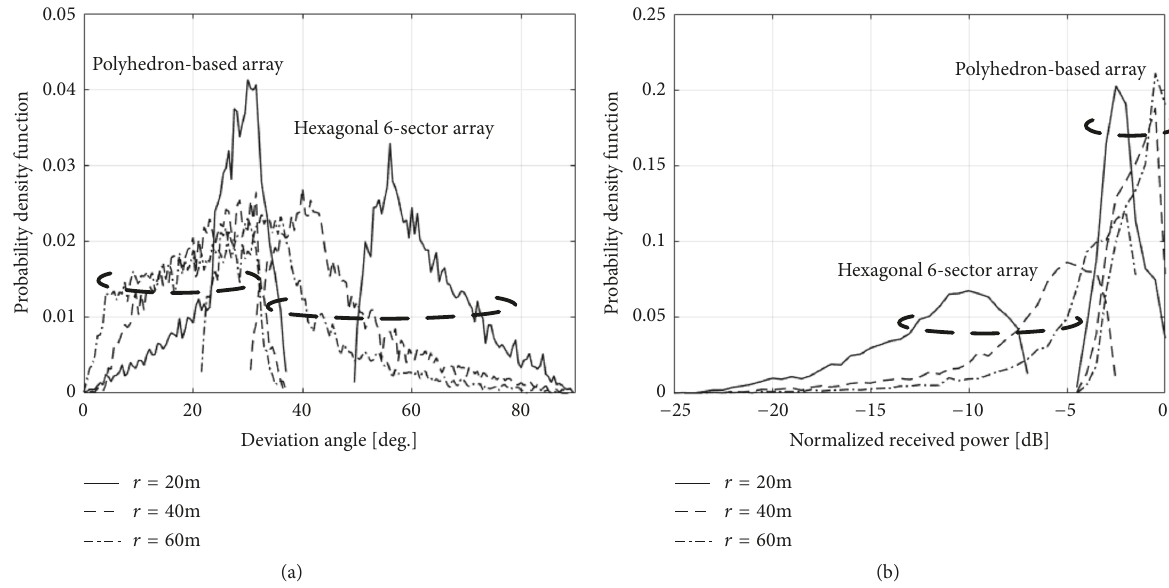
Figure 7: Performance for the 2D UE distribution: (a) deviation angles and (b) the received